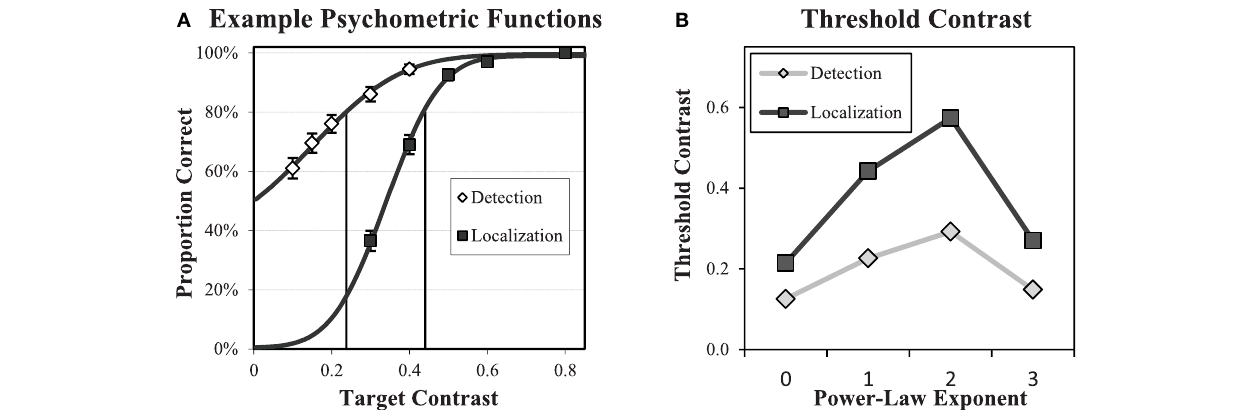
FIGURE 6 | Psychometric functions and thresholds. An example of detection and forced-localization psychometric data (A) and fitted psychometric functions are shown for one subject in one condition. Error bars = ± 1 s.e. The fitting function is a cumulative Gaussian distribution that is used to determine the contrast threshold for 80% correct performance in the